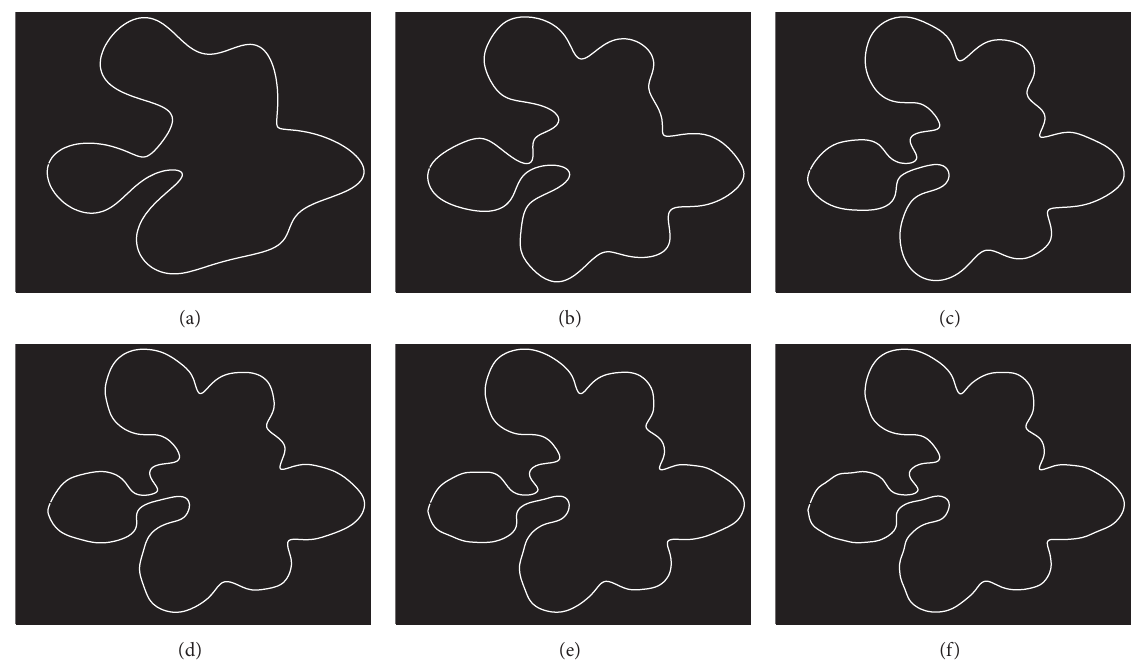
Figure 3: Contour reconstruction. (a)–(f) Contour reconstruction with 10, 20, 30, 40, 50, and 60 harmonics numbers,